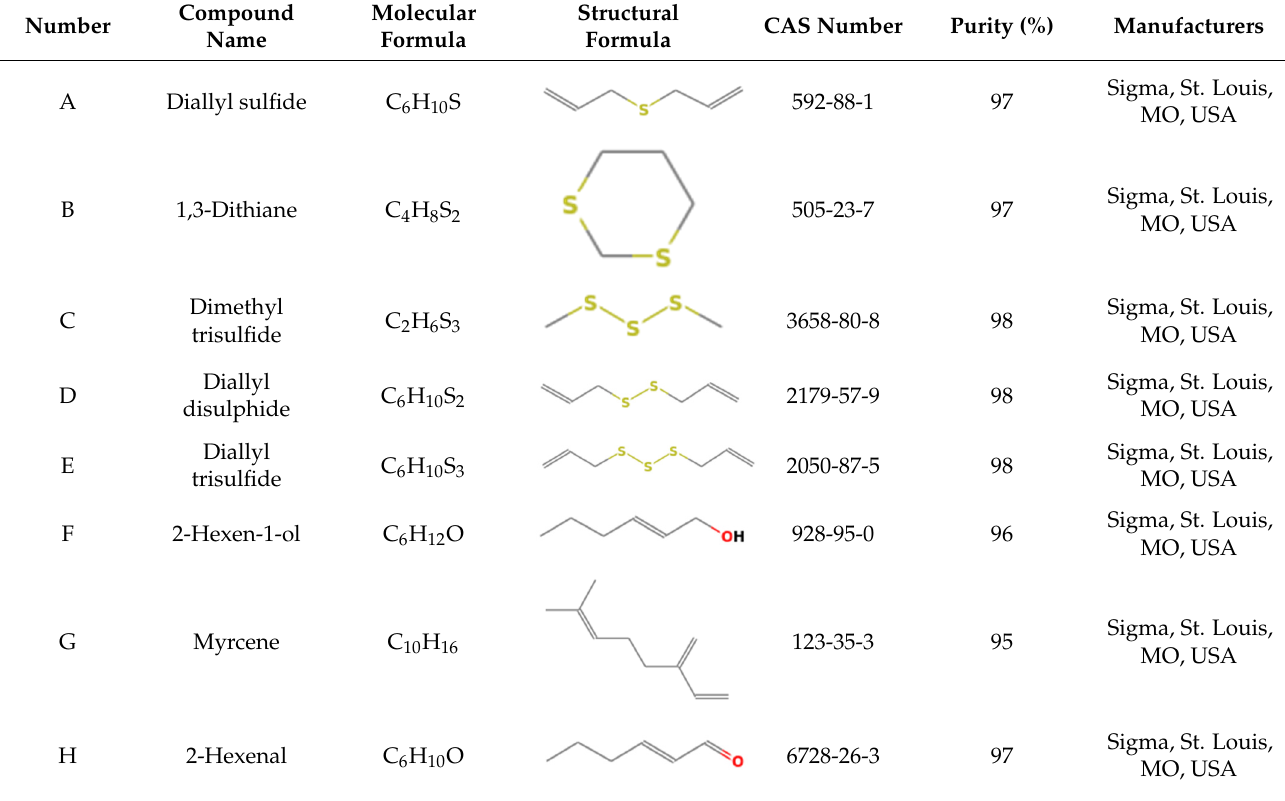
Table 1. Odorant stimulus for EAG.